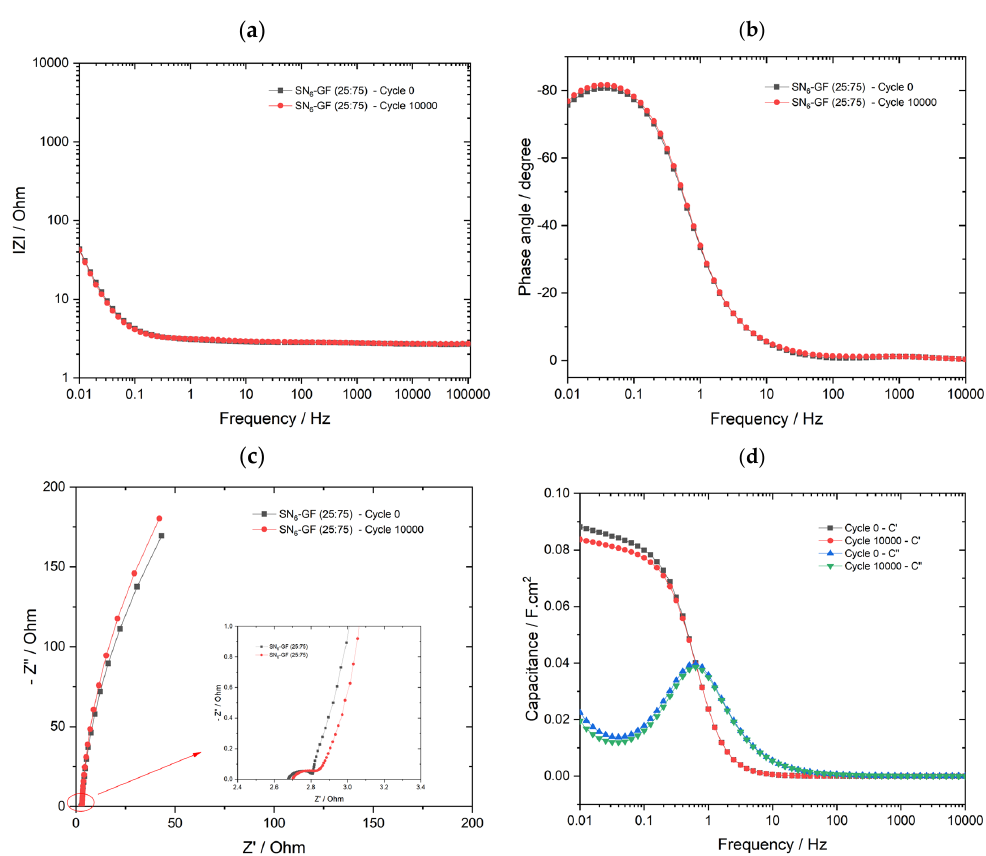
Figure 7. Electrochemical impedance spectroscopy results for co-doped graphene sample in 1 M Na 2 SO 4 electrolyte, SN 6 –GF (25:75): ( a ) magnitude Bode plots; ( b ) Bode plots vs. phase angle; ( c ) Nyquist plot; and ( d ) complex capacitance analysis.